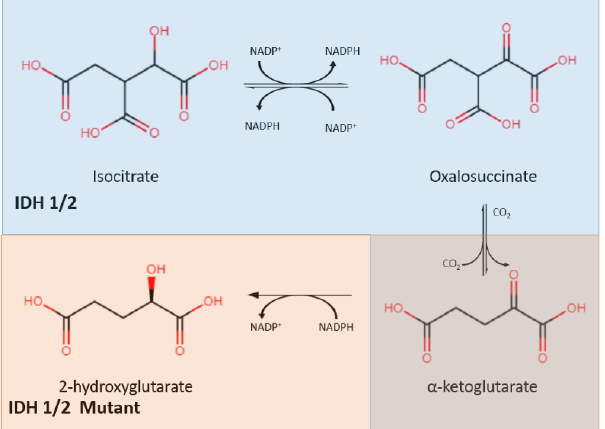
Figure 1. The IDH1/2 enzyme converts isocitrate into α-ketoglutarate (shown in the blue) while the Figure 1. The IDH1 / 2 enzyme converts isocitrate into α -ketoglutarate (shown in the blue) while the mutant IDH1/2 enzyme converts α-ketoglutarate into 2-hydroxyglutarate (shown in orange). IDH: mutant IDH1 / 2 enzyme converts α -ketoglutarate into 2-hydroxyglutarate (shown in orange). IDH: isocitrate dehydrogenase. isocitrate